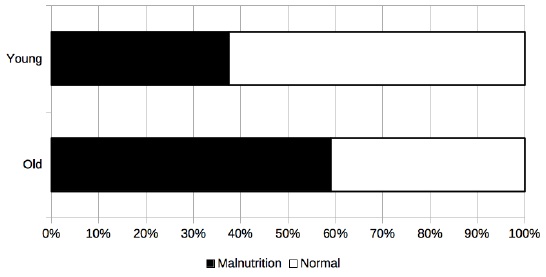
Figure 5: Prevalence of malnutrition in young and older